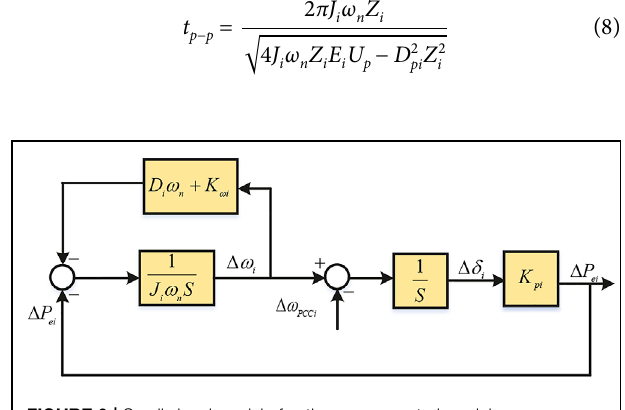
FIGURE 6 | Small signal model of active power control